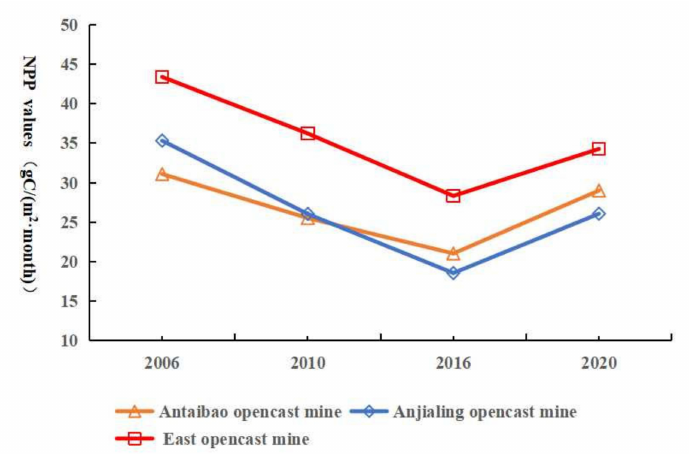
Figure 5. NPP change trend of three opencast mines.